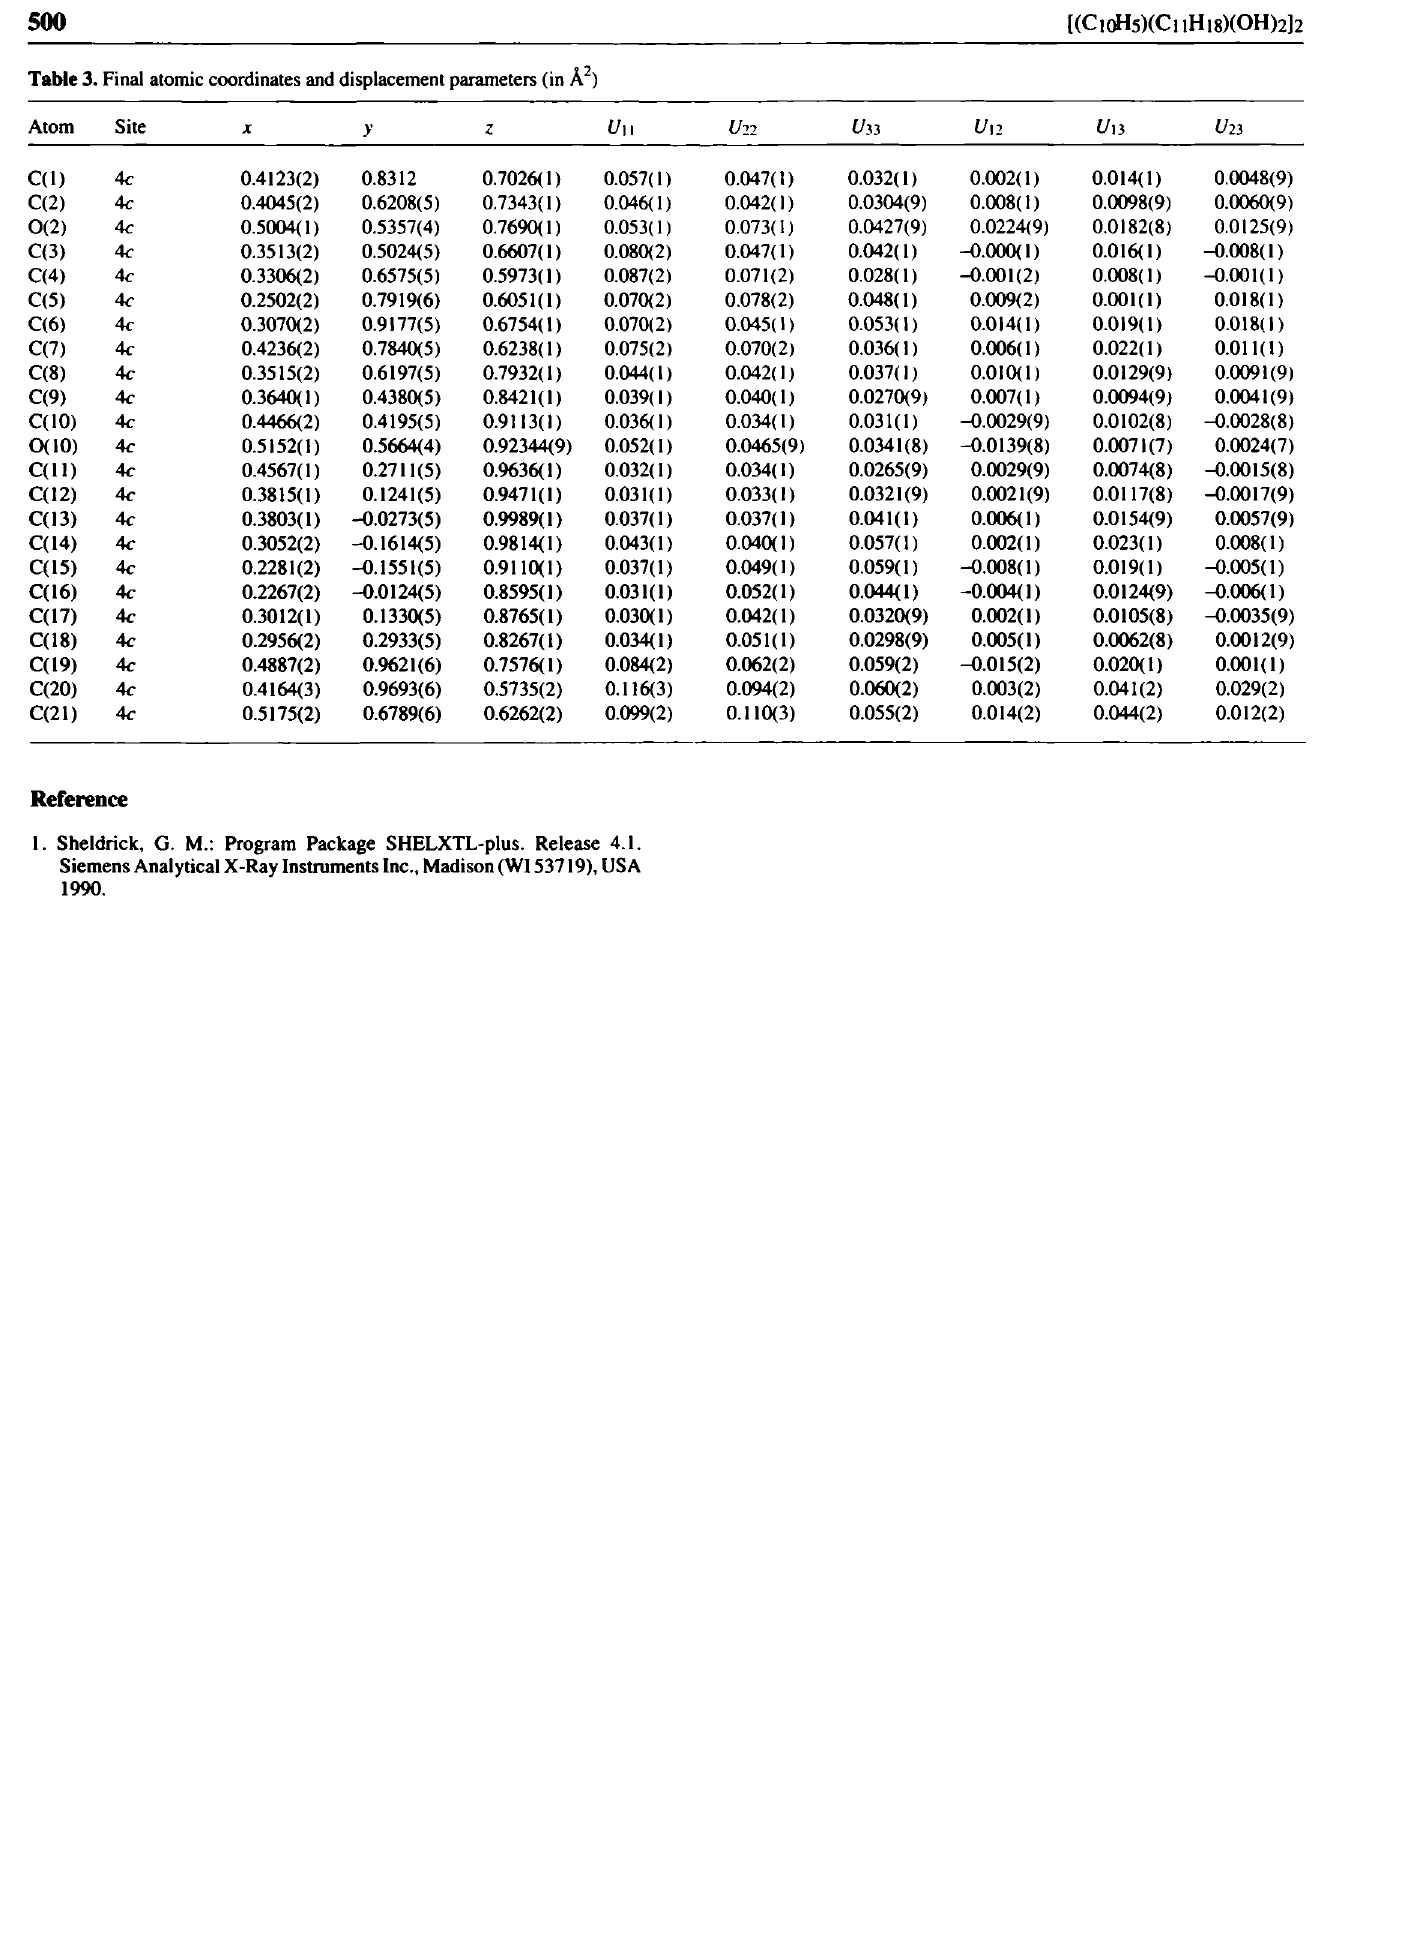
Table 3. Final atomic coordinates and displacement parameters (in Â^)